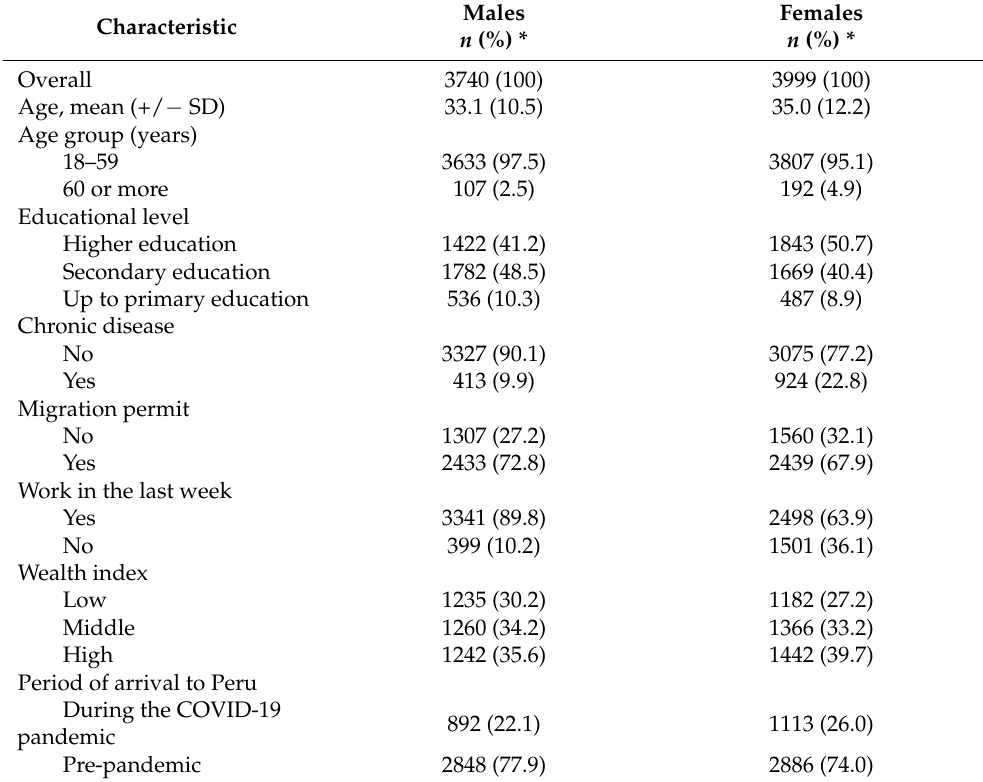
Table 1. Characteristics of the Venezuelan migrants and refugees included in this study, ENPOVE